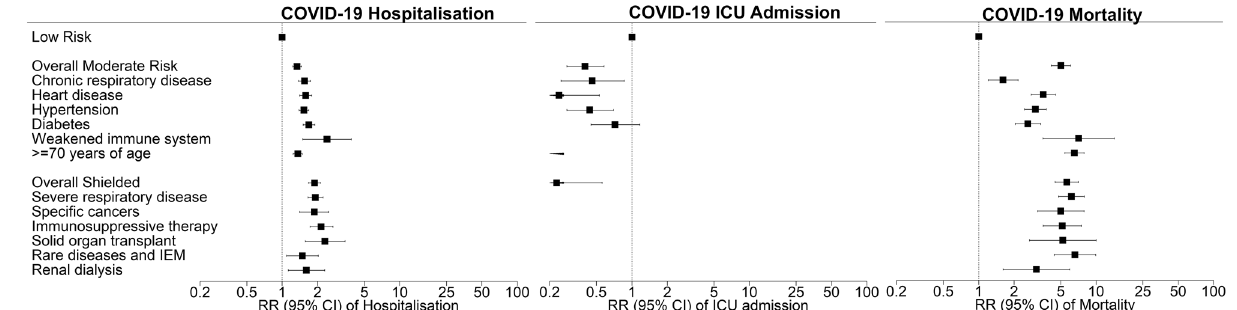
Figure 2. Associations* between risk categories and risk criteria and COVID-19 outcomes among confirmed cases. *Adjusted for sex, deprivation quintile, and other risk categories. RR relative risk; CI confidence interval; IEM inborn errors of